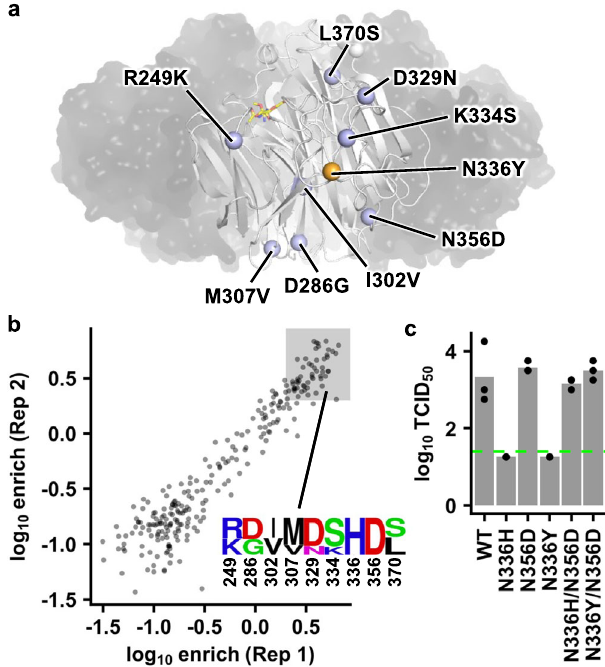
Fig. 3 | Permissive mutations for NA N336Y in Bil69. a Locations of natural substitutions fromBil69to Bil71 areshownasbluesphereson one protomerof NA thatisin white cartoon representation, while the other three protomersare shown assemitransparentblacksurface(PDB3TIA) 21 .ThelocationofN336Yisshownasan orange sphere. Sialic acid in the active site is shown as yellow sticks. b High- throughput identi fi cation of permissive mutations for N336Y in Bil69. The fre- quency enrichment of each variant in the post-passaged mutant library is shown. The amino acid sequences of variants with at least 2-fold enrichment (log 10 enrichment ≥ 0.3)inthepost-passagedmutantlibrariesofbothbiologicalreplicates are represented by a sequence logo. c The replication fi tness of different Bil69 mutants was examined by a virus rescue experiments. Each bar represents the mean of three independent biological replicates. Each datapoint represents one biological replicate. Virus titer was measured by TCID 50 . The green dashed line representsthelowerdetectionlimit.SourcedataareprovidedasaSourcedata fi